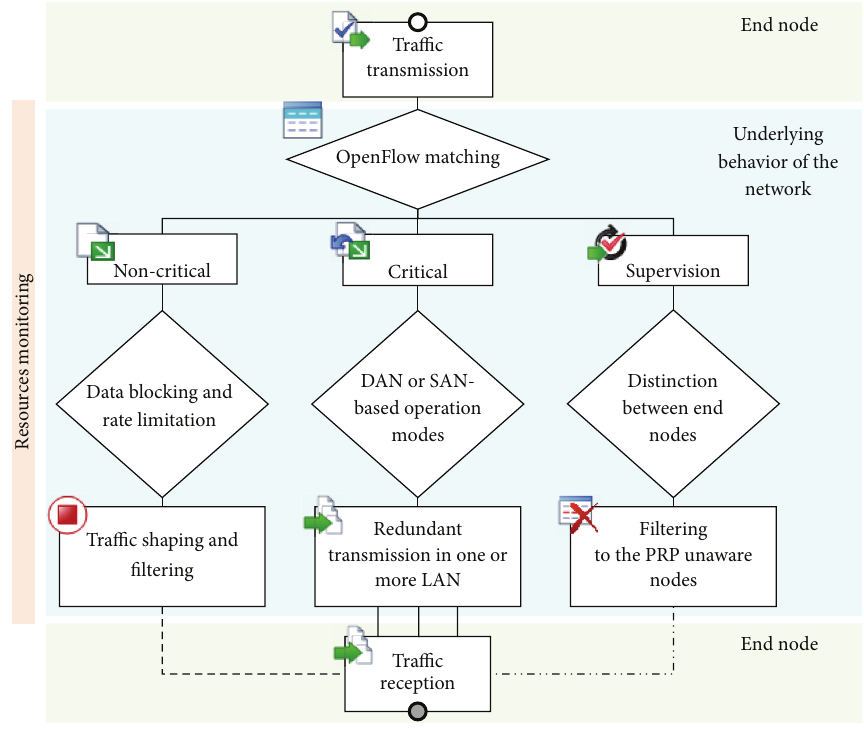
Figure 4: Process flow for identifying and forwarding data